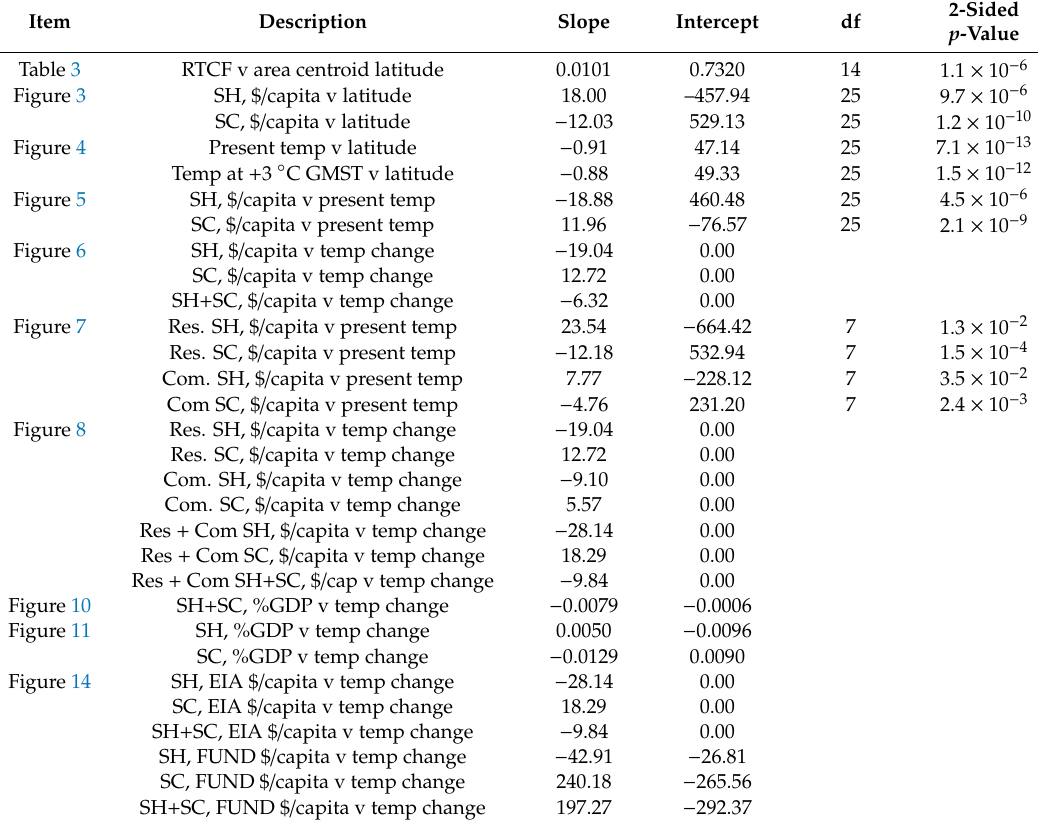
Table A5. Summary of the regression analyses